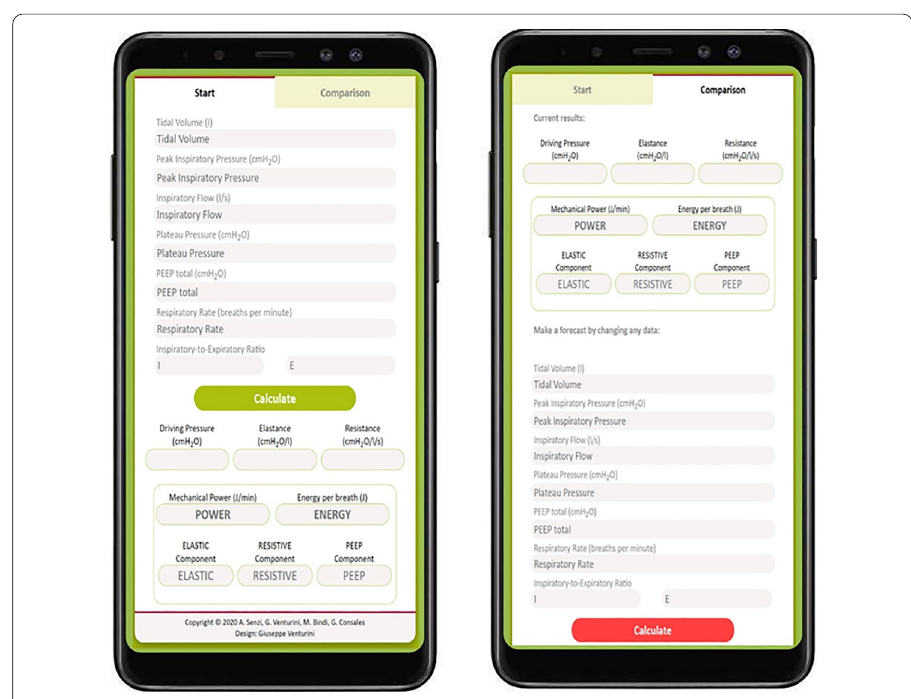
Fig. 1 Main section of the “PowerApp” with the calculation tool for mechanical power and its relative components (elastic, resistive and PEEP component). The first section-tab “Start” allows to enter data easily available bedside from the ventilator; the output section firstly shows the calculated driving pressure (cmH 2 O), elastance (cmH 2 O/l) and inspiratory airway resistance (cmH 2 O/l/s), followed by mechanical power (J/min), energy per breath (J) and its relative components (%). The next section-tab “Comparison”